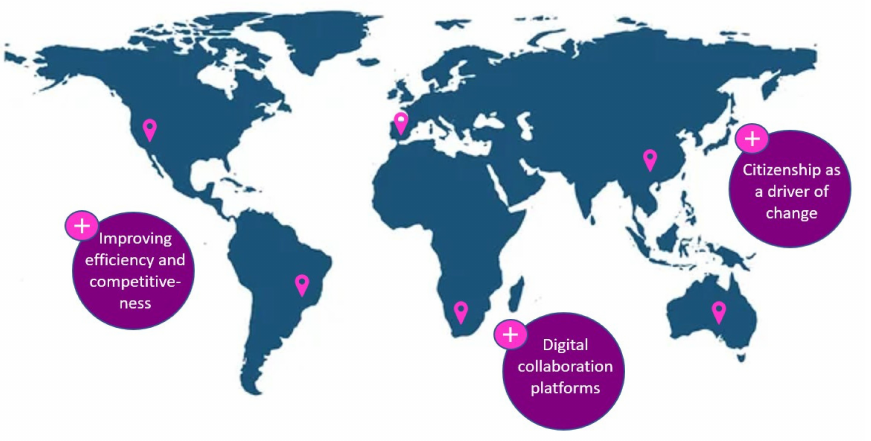
Figure 2. Essential elements of the work scenario. Source: own